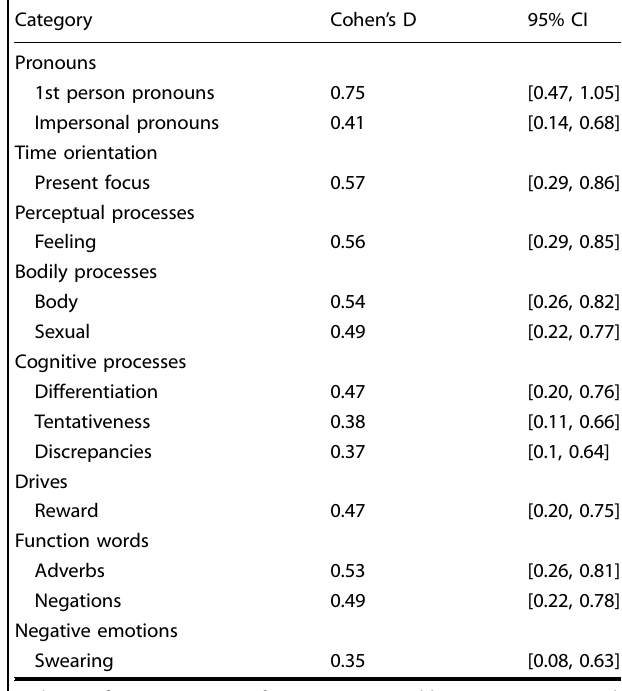
Table 2. Linguistic Enquiry Word Count (LIWC) categories signi fi cantly associated with language used in Facebook posts of healthcare super-